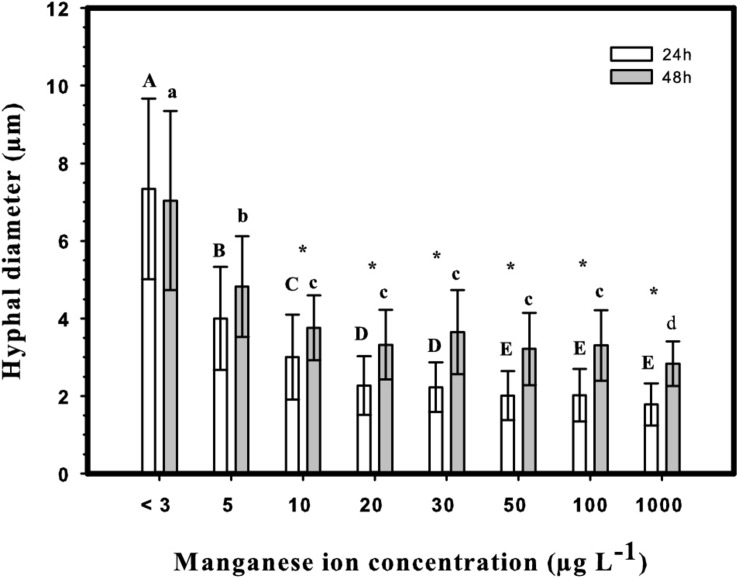
Hyphal diameters at 24 h (white columns) and 48 h (gray columns) after inoculation in shake-flask cultures. Upper case letters: significantly different groups at 24 h (p < 0.05). Lower case letters: significantly different groups at 48 h (p < 0.05). Asterisks indicate significant changes between 24 and 48 h in the same culture (p < 0.05). Statistical analysis was performed using ANOVA with Holm–Sidak Test for pairwise comparisons.